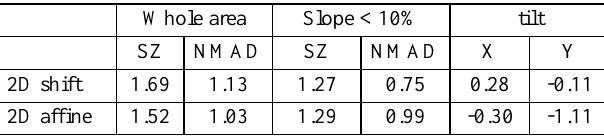
Table 8. Comparison of WorldView-2 model 2 DSM